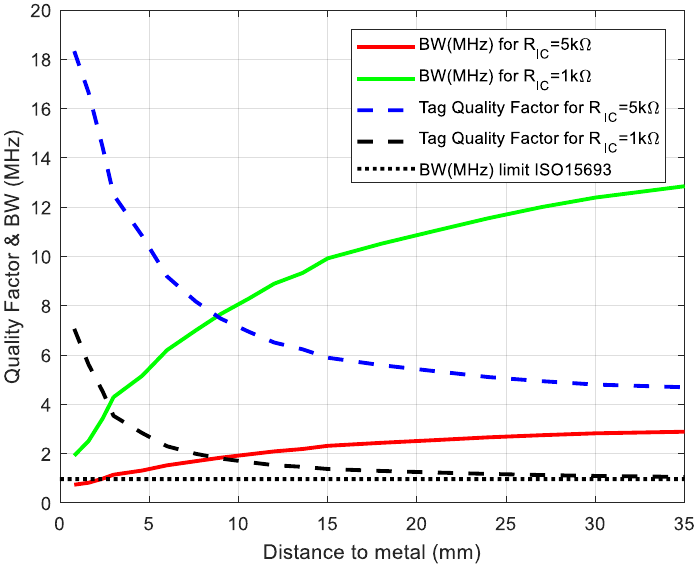
Figure 8. Tag quality factor and bandwidth (BW) as a function of the distance to metal depending on chip resistance R c . The BW limit for ISO 15693 is also shown.